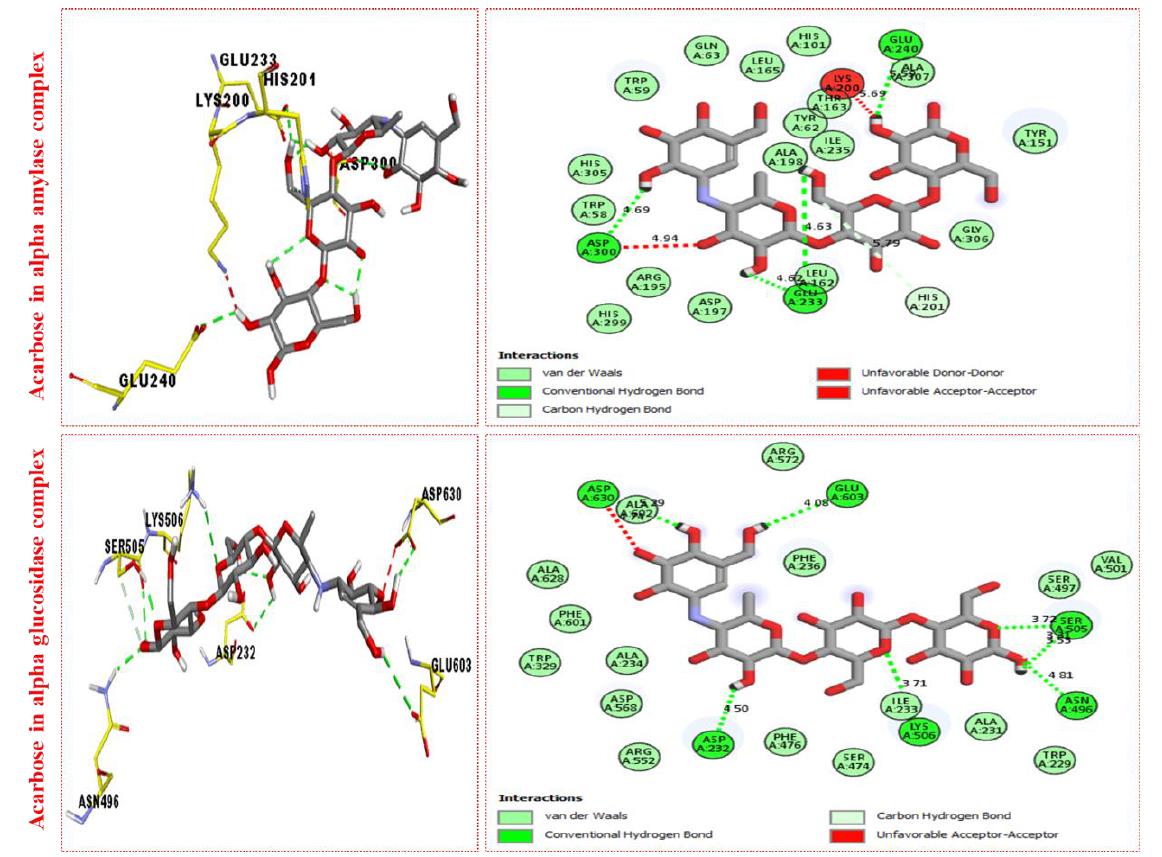
Figure 13. The PLI profile for potent compounds against α‐ amylase and α‐ glucosidase represents the surface of the corresponding enzyme and indicates the PLI profile for acarbose.